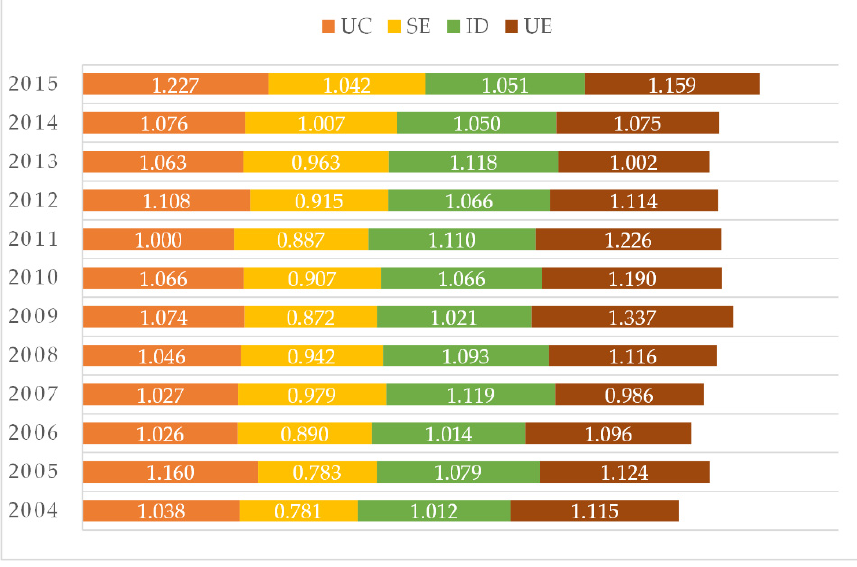
Figure 5. The LCCC of the cities in the HCUA during 2004–2015. Table 4. Classification standards of the LCCC in the HCUA. Gradient